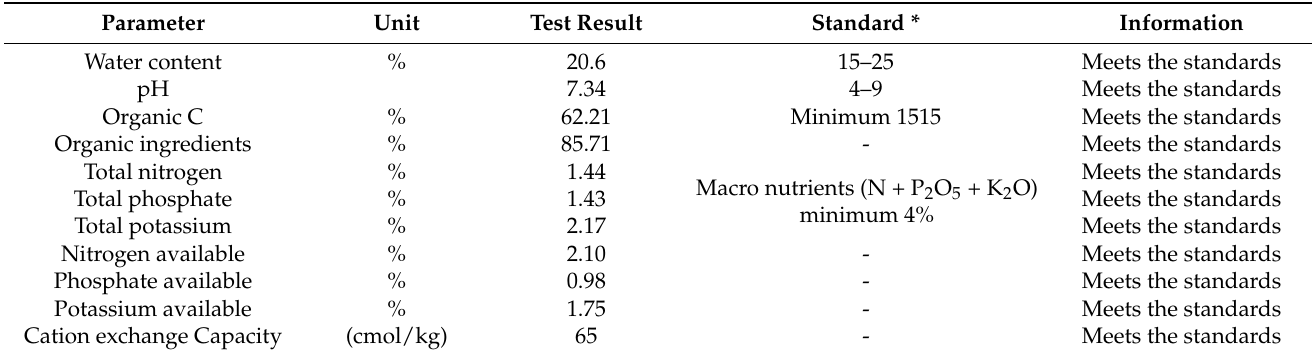
Table 1. Chemical content of corn cob organic fertilizer.